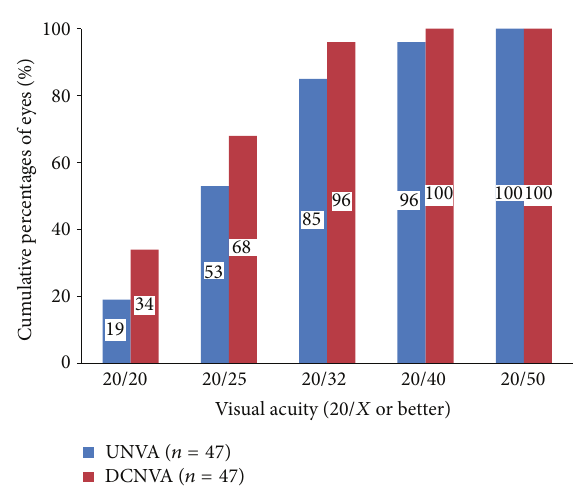
Figure 2: Monocular uncorrected near visual acuity (UNVA) and distance-corrected near visual acuity (DCNVA) at 30 cm at 6 months.